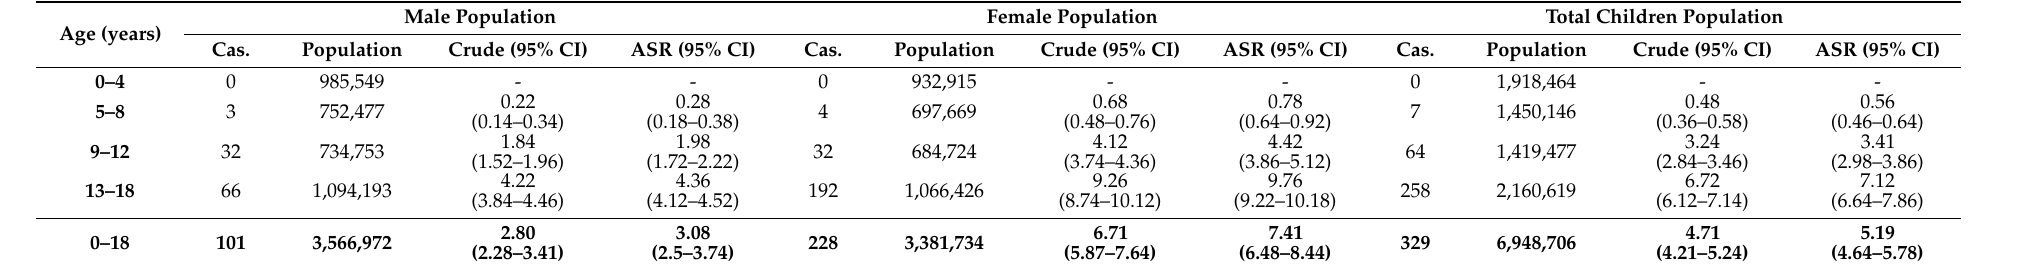
Table 2. Age- and sex-specific prevalence (per 100,000) of paediatric-onset multiple sclerosis patients in Poland, current as of 31 December 2019 a